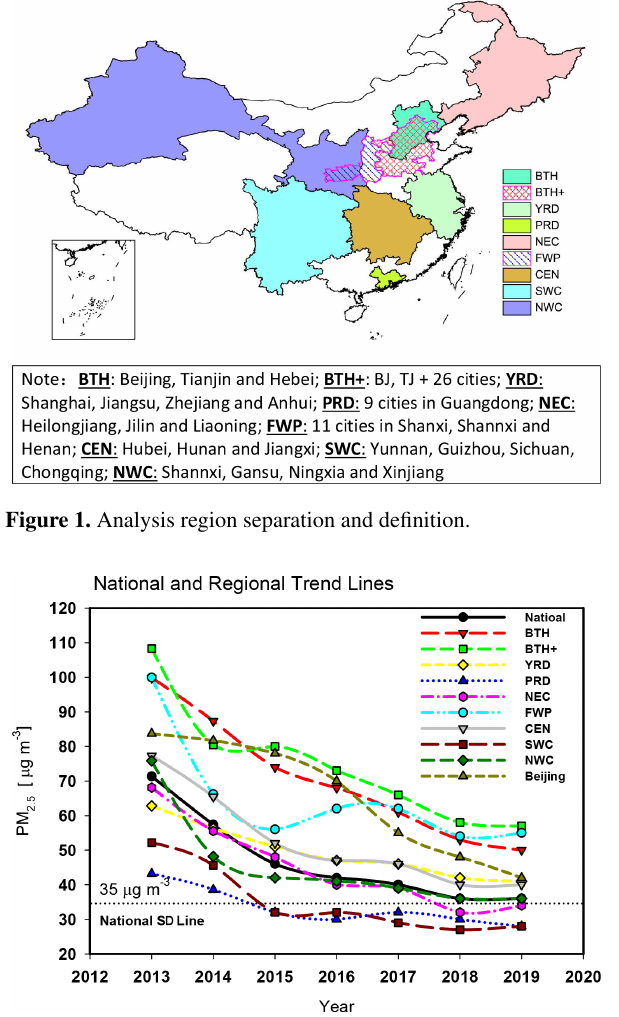
Figure 2. National and regional trend lines of PM 2 . 5 in China from 2013 to